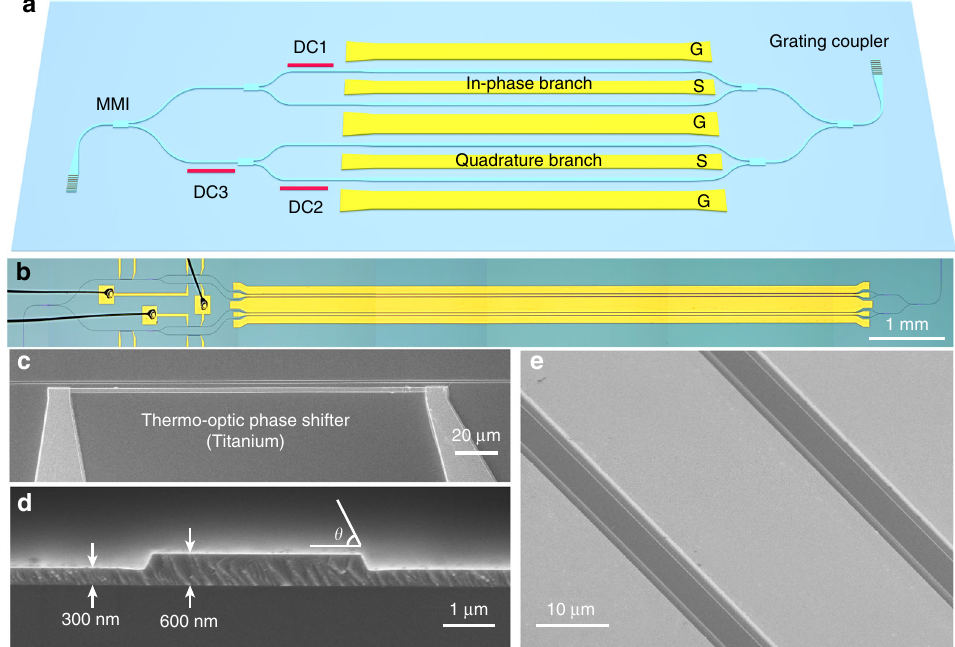
Fig. 1 IQ modulator on the LNOI platform. a Schematic of an LNOI-based IQ modulator. b Microscope image of the fabricated chip. c Scanning electron microscopy (SEM) image of the thermos-optic phase shifter. d SEM image of the cross-section of the LN waveguides. e SEM image the gold electrodes and the LN waveguides.